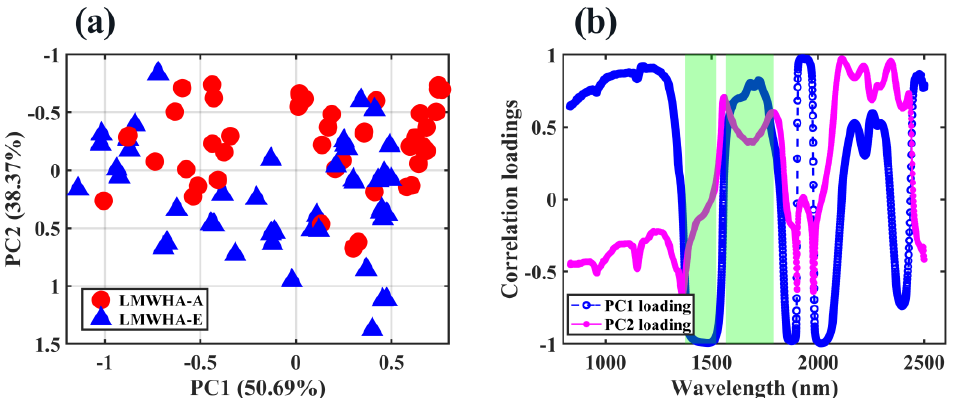
Figure 5. ( a ) 2D score plot and ( b ) correlation loadings plot of PC1 and PC2 of LMWHAs.